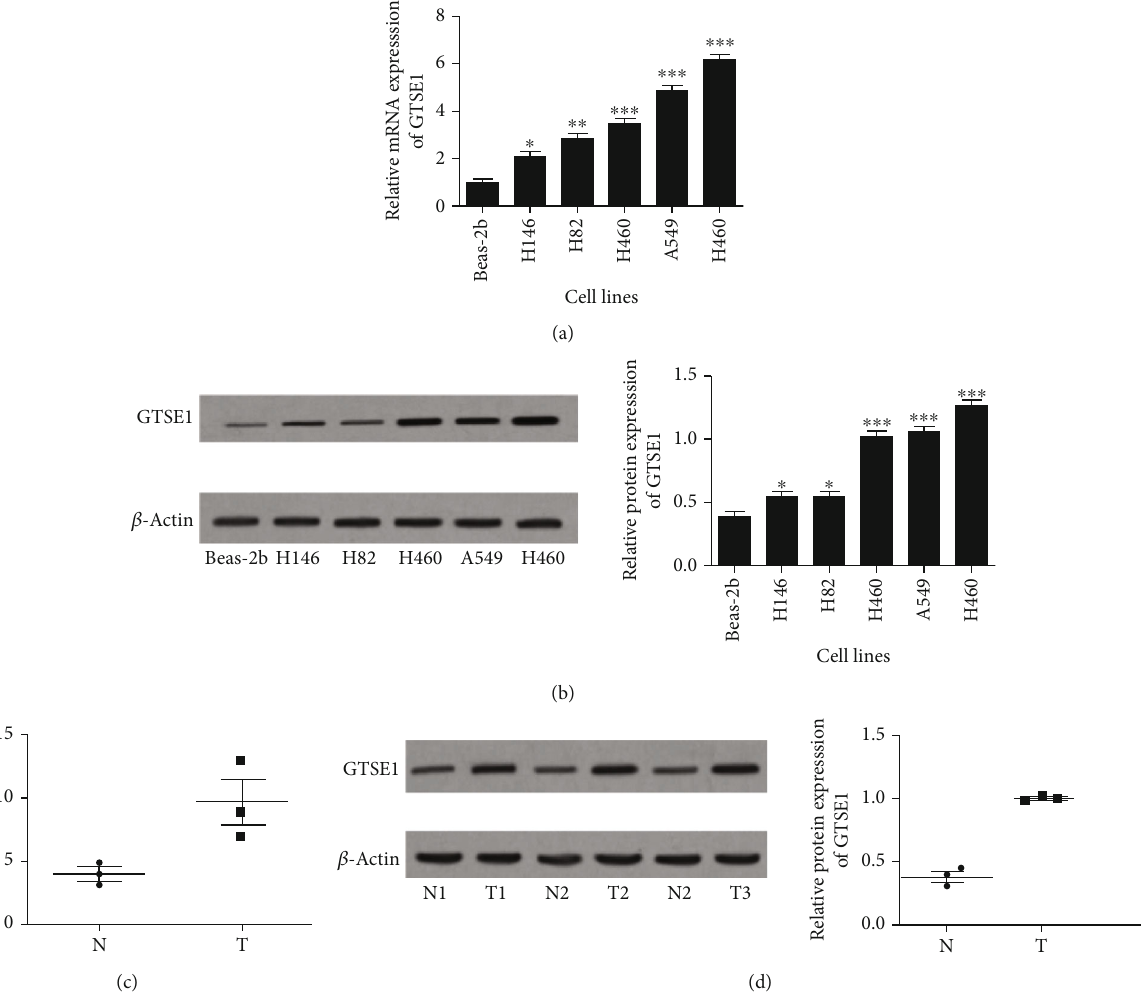
Figure 2: GTSE1 expression in lung cancer tissues and cells. (a) RT-PCR analysis of GTSE1 mRNA in lung cell lines. (b) Western blotting analysis of GTSE1 protein in lung cell lines. (c) RT-PCR analysis of GTSE1 mRNA levels in lung cancer tissues. (d) Western blotting analysis of GTSE1 protein in lung cancer tissues. All the values of three independent experiments were presented as means ± SD . ∗ p < 0 : 05 and ∗∗ p < 0 : 01